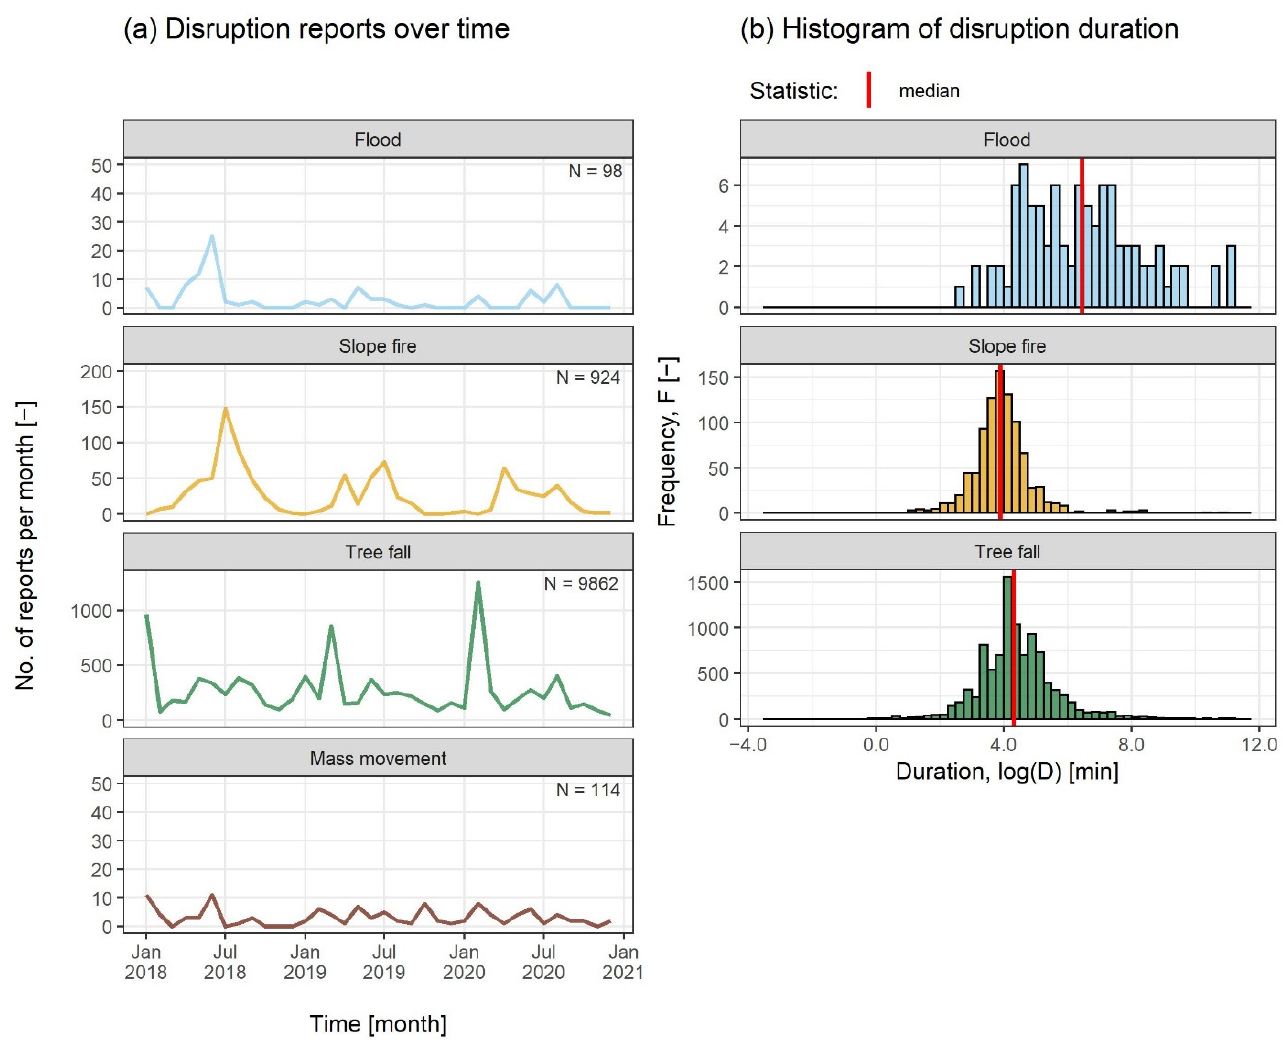
Figure 3. Statistics on natural hazard events: ( a ) disruption reports over time by type of natural hazard; ( b ) histogram of disruption duration. Note: For mass movements, no information on disruption duration was provided.